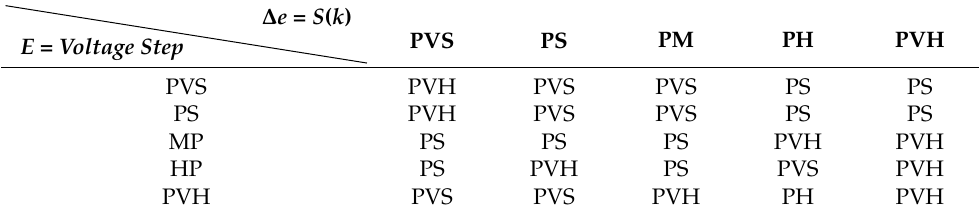
Table 1. Fuzzy rules table for the MP&O MPPT.